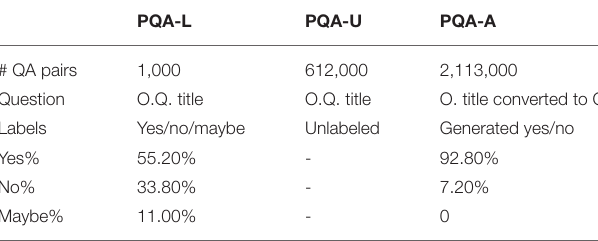
TABLE 1 | Profile of